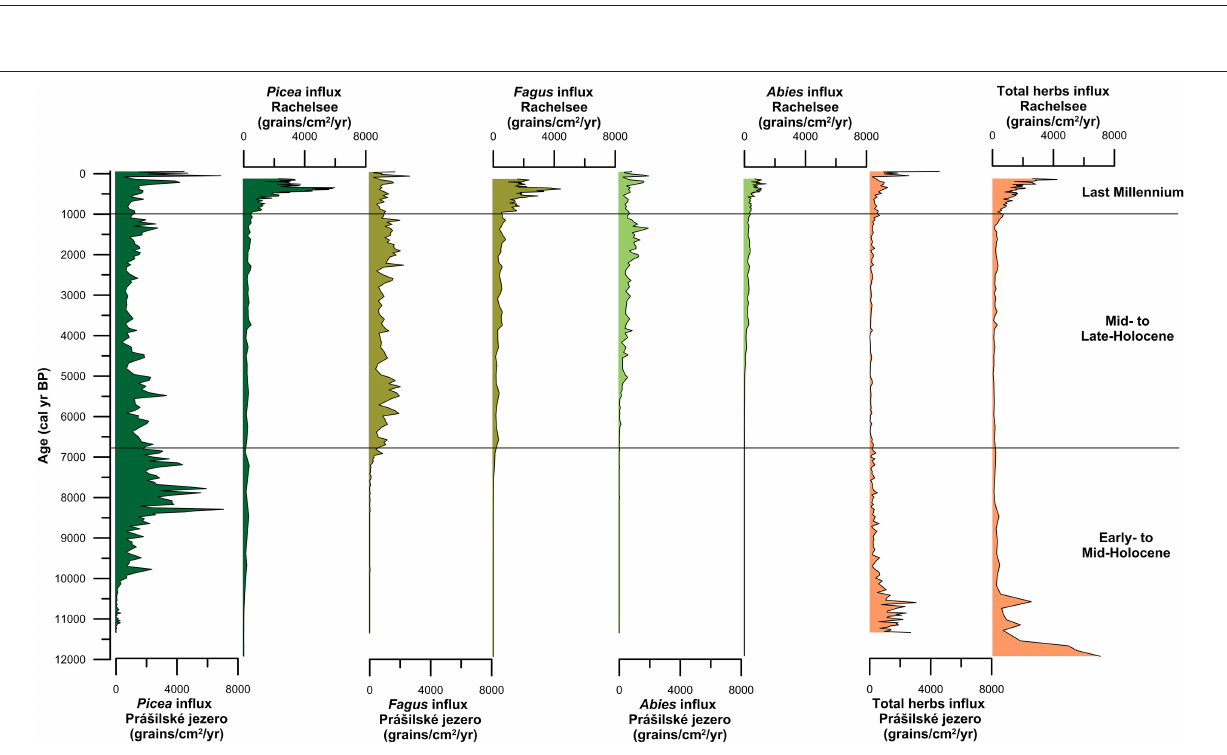
Frontiers in Plant Science | www.frontiersin.org